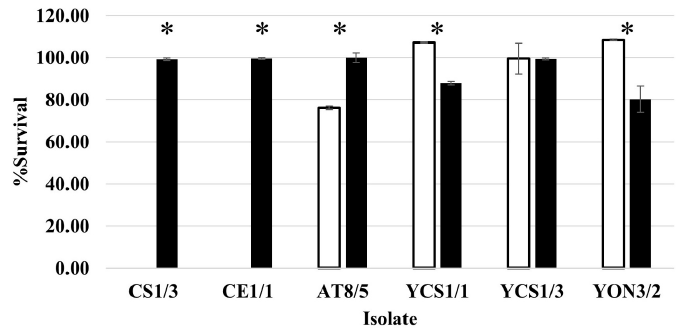
Figure 2. Percentage of survival of individually selected probiotics at simulated GI tract for 7 h. White bars: tested group; black bars: control group; *: statistically significant difference ( p < 0.05) compared with their control.